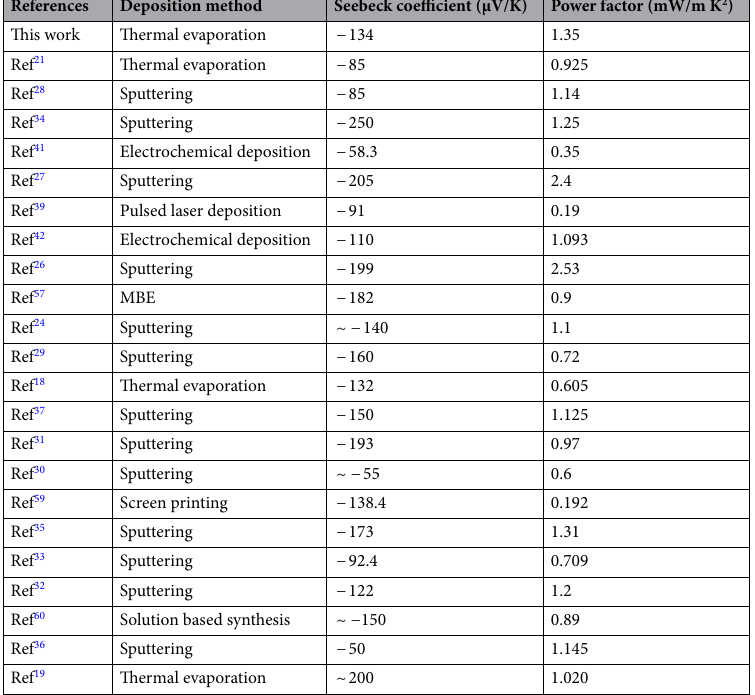
Table 4. Comparison of the Bi–Te thin film properties and growth methods published in the literature (since year 2011) with the present